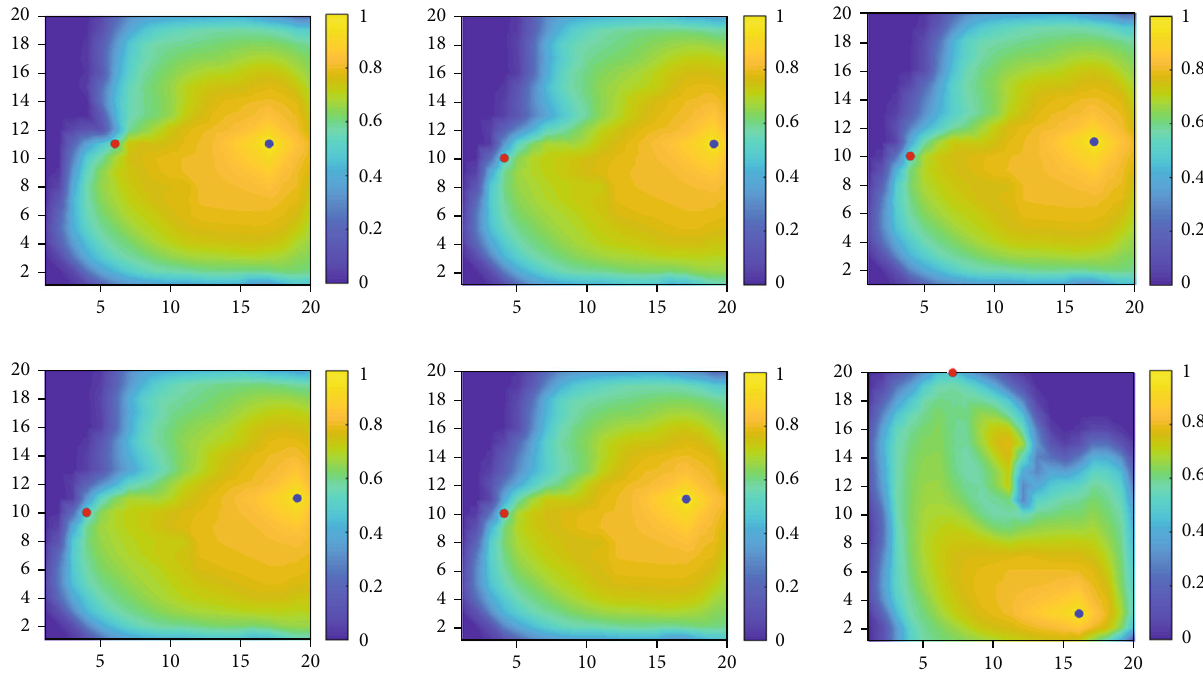
Figure 11: The optimal well locations plotted on the water saturation fi eld.